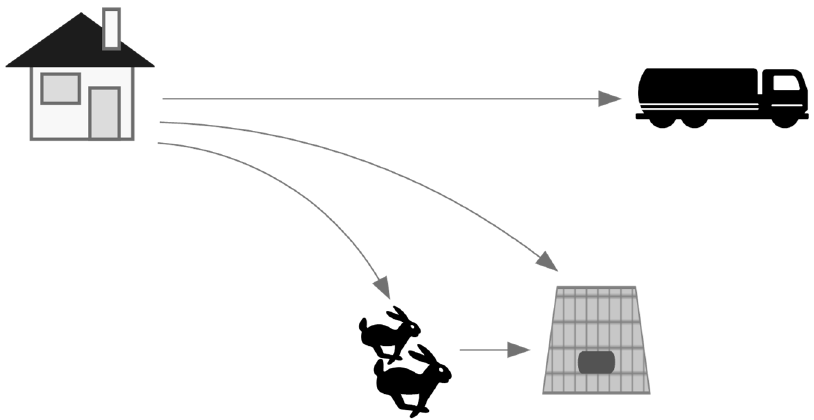
Figure 1. Onsite house minimization of organic waste.